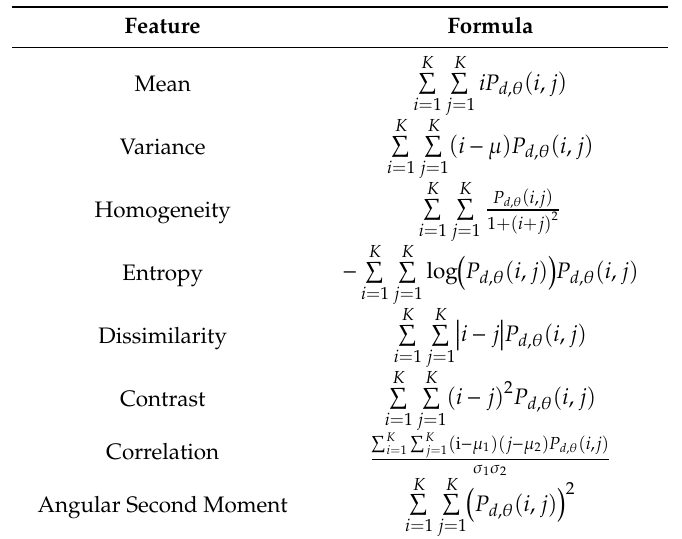
Table 2. Texture feature parameter formula based on the Gray level co-occurrence matrix (GLCM).